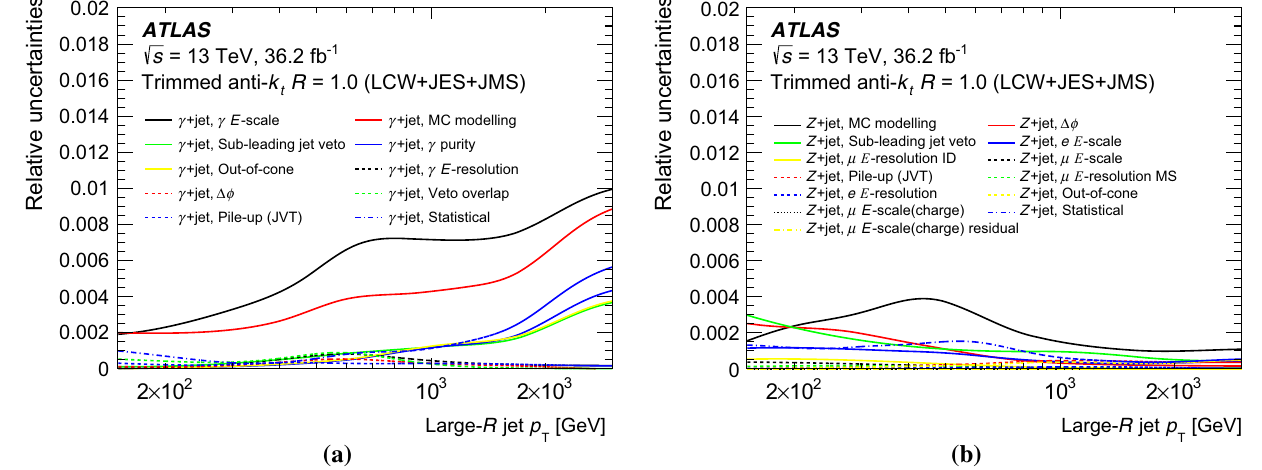
in combination, incorporating the weight of the method from which it originates. The nuisance parameters related to the γ +jet method (both directly and through their effect on the multijet balance) are shown in the left panel, and those of the Z+jets method are shown in the right panel. The lines shown are smoothed using a sliding Gaussian kernel